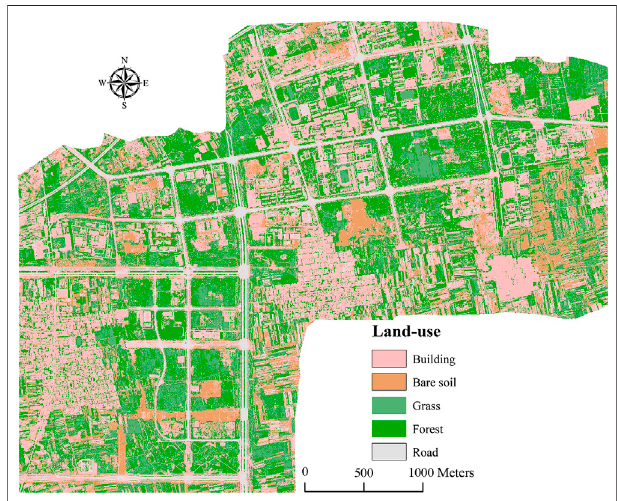
FIGURE 2 | Land-use